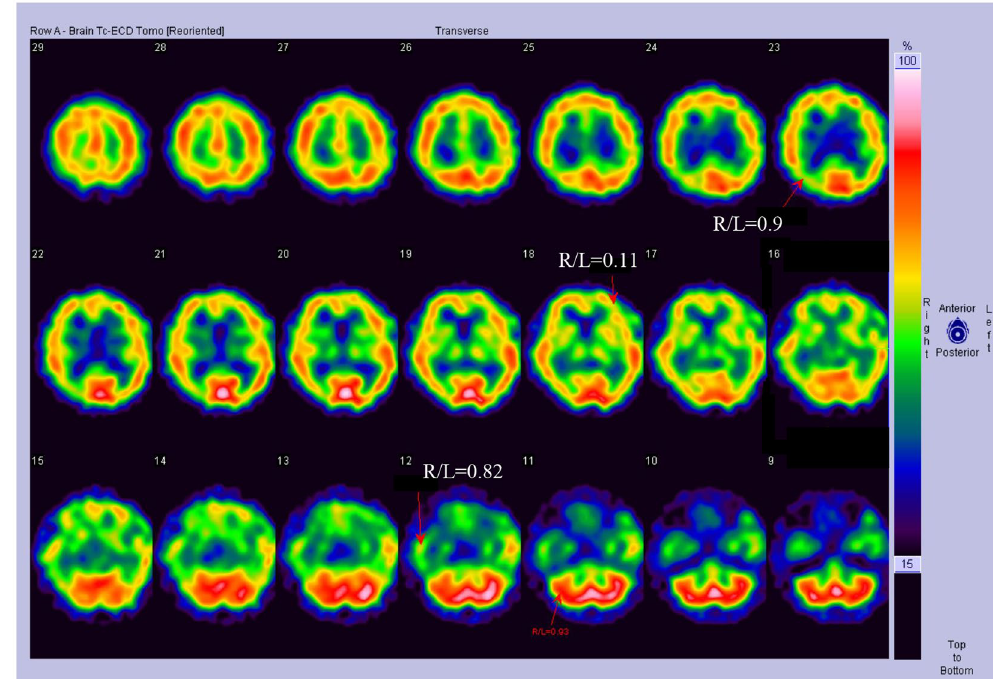
Figure 2. SPECT analysis of FFI patients. Patient 1 S PECT image showing reduced blood flow perfusion in bilateral temporal lobes, bilateral basal ganglia, and bilateral